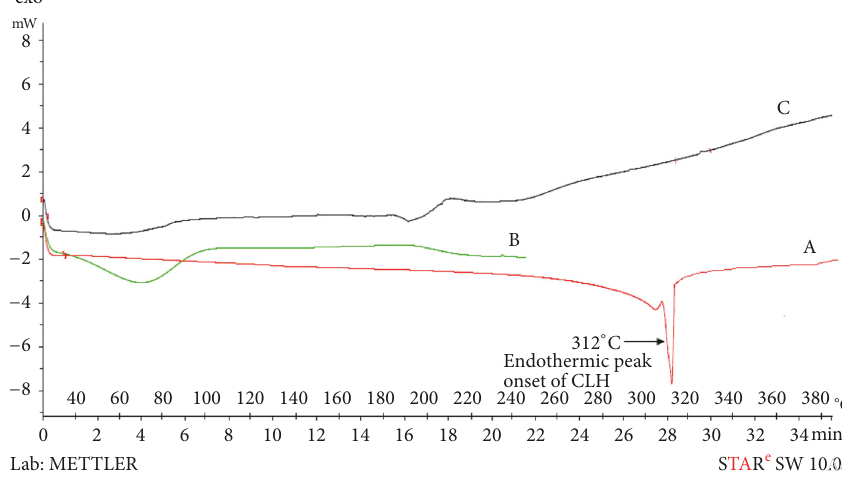
Figure 6: DSC thermogram of (A) pure drug (CLH), (B) placebo batch, and (C) optimized FDBF (F6) formulation.